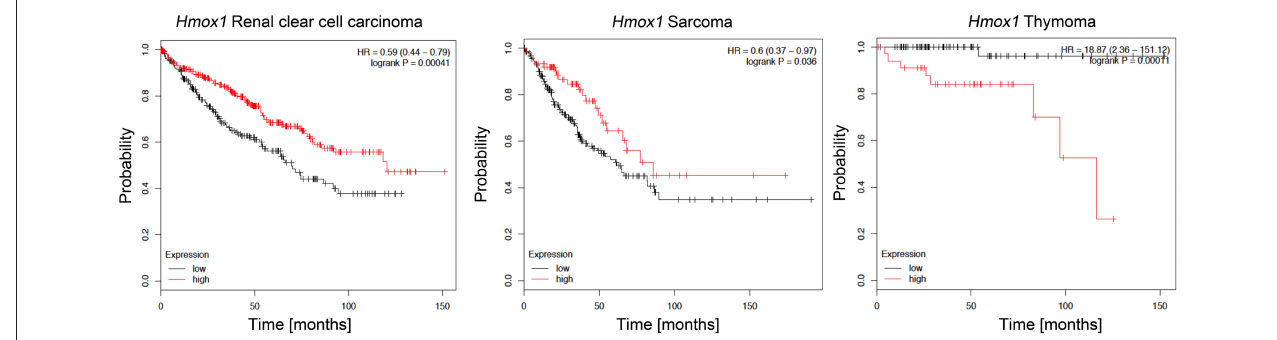
FIGURE 5 | Kaplan-Meier survival plots for patients stratified by HMOX1 expression. Kaplan-Meier plots were obtained by using the Kaplan-Meyer plotter online database tool (122). Patients were stratified for high and low expression of HMOX1 in renal clear cell carcinoma, sarcoma, and thymoma